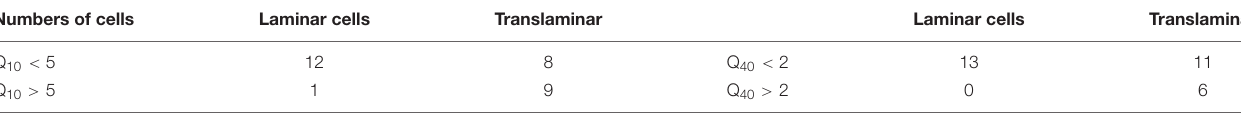
TABLE 3 | Comparison of numbers of laminar and translaminar cells with broad or sharp